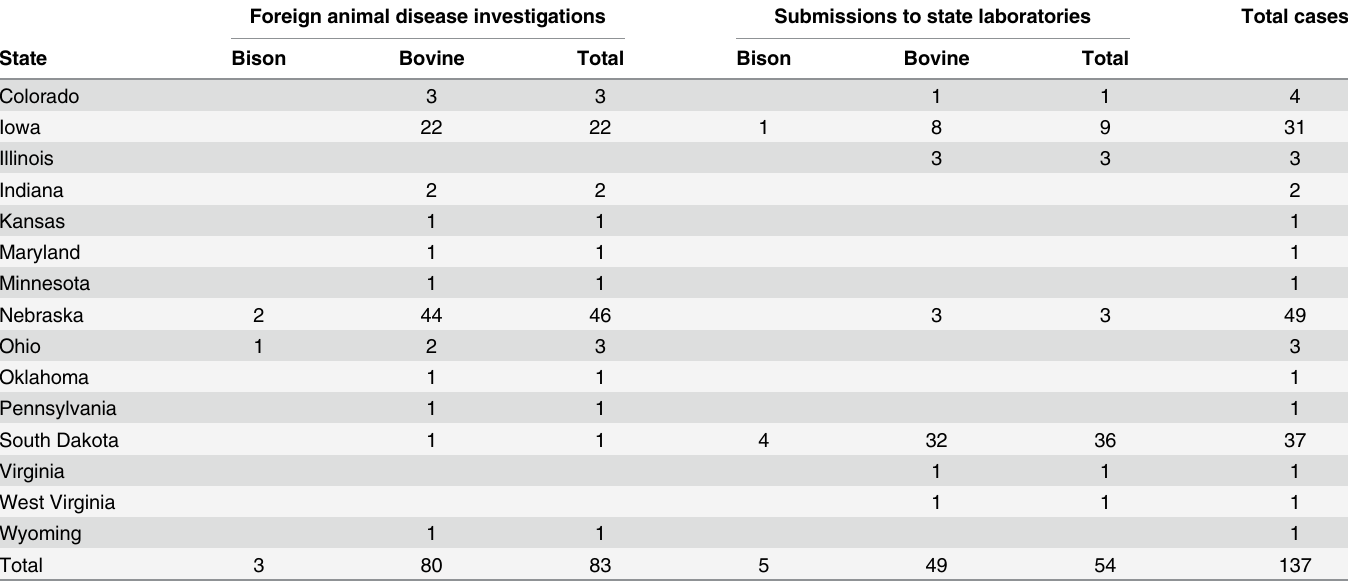
Table 2. EHD cases in cattle and bison from June 1 to December 31,